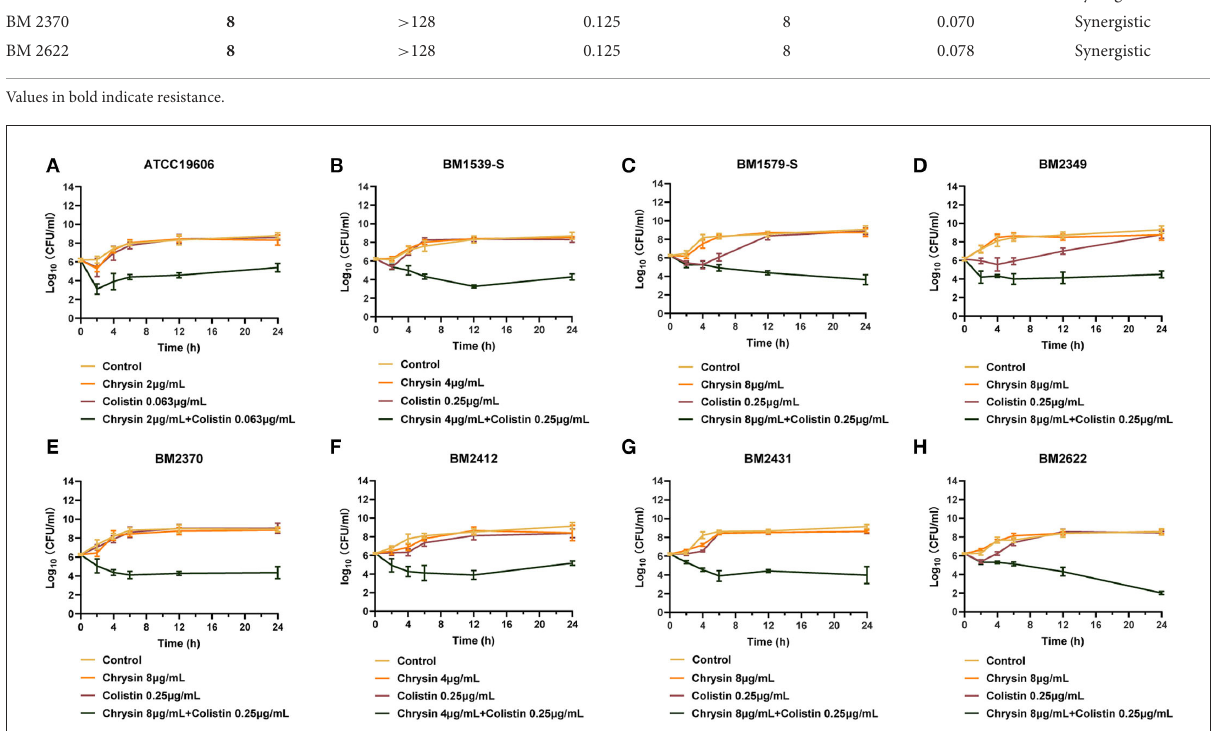
FIGURE1 Time-killing curves of colistin and chrysin alone or in combination against Acinetobacter baumannii . (A) ATCC 19606, (B) BM1539-S, (C) BM1579-S, (D) BM2349, (E) BM2370, (F) BM2412, (G) BM2431, and (H)